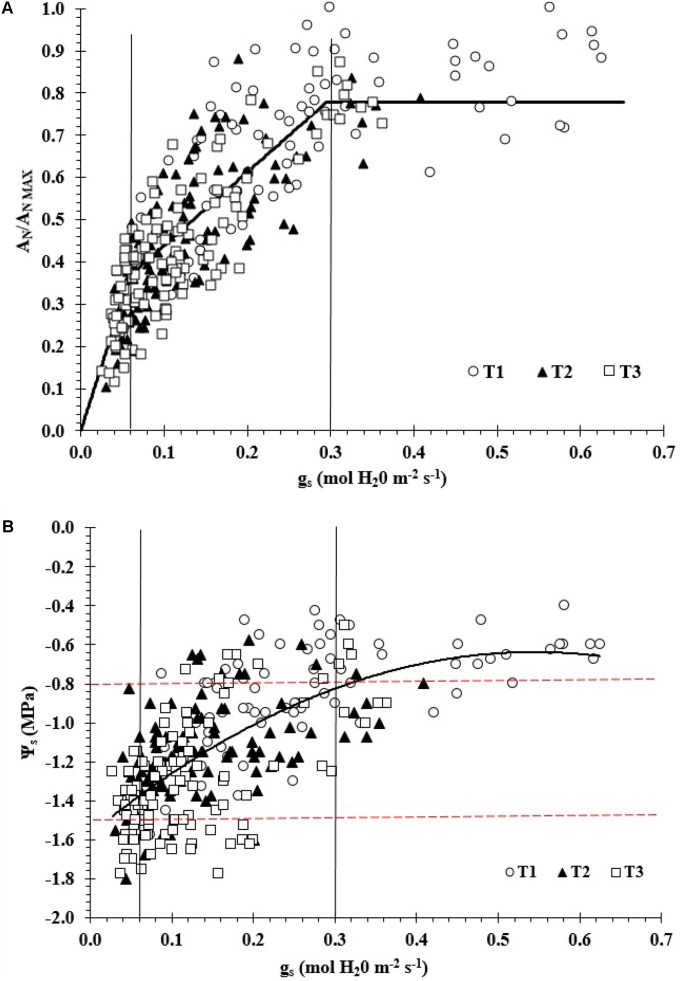
(A) Relationship between AN/ANmax ratio versus stomatal conductance (gs) vineyard (AN/ANmax = 1.02 + 0.25ln(gs); R2 = 0.72) and (B) relationship between midday stem water potential (Ψs) versus gs in a drip-irrigated Carménère vineyard (Ψs = –3.157gs2+3.43gs–1.571; R2 = 0.5). AN and ANmax are actual and maximum values of net CO2 assimilation, respectively.